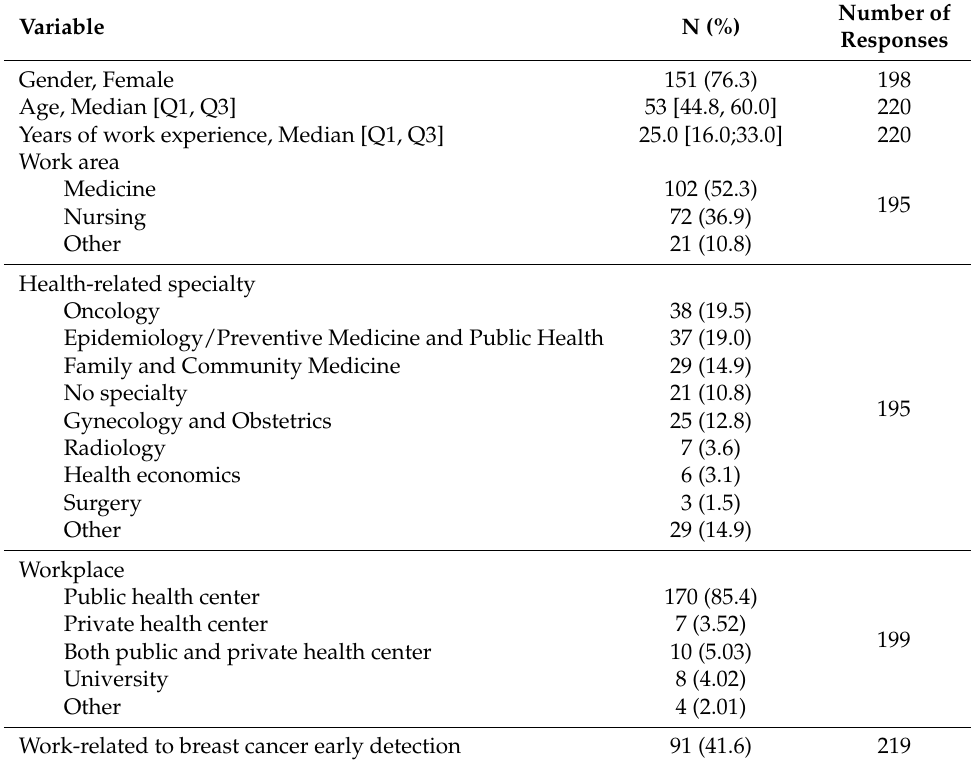
Table 1. Demographic and work characteristics of the 220 participant health